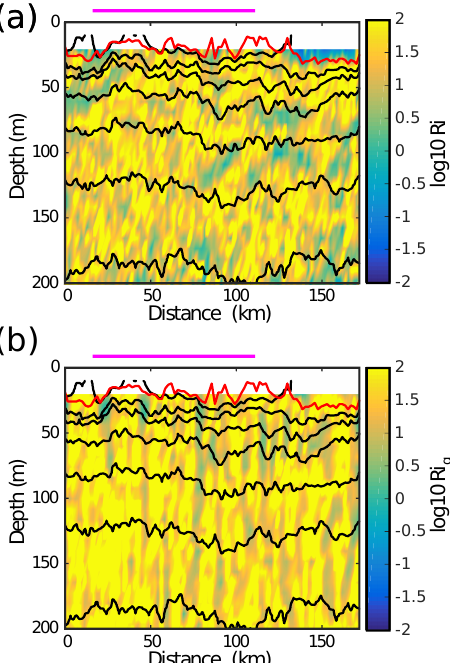
Figure 5. Calculated (a) Ri and (b) Ri g for MVP T4. Density con- tours are superimposed in black and MLD in red, with magenta in- dicating the region inside the bloom, similar to Fig. 2e. Please note the log 10 color